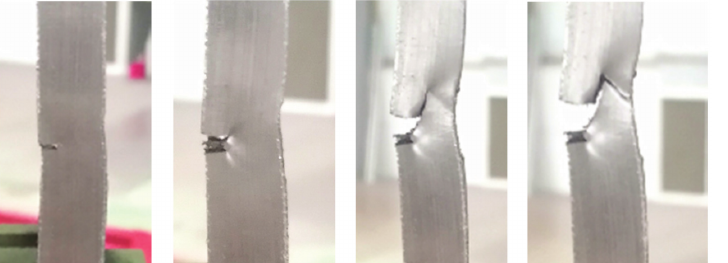
Figure 13. Tensile test specimens during the experiment (weld metal sagging and incomplete root penetration) from the initial state to fracture.